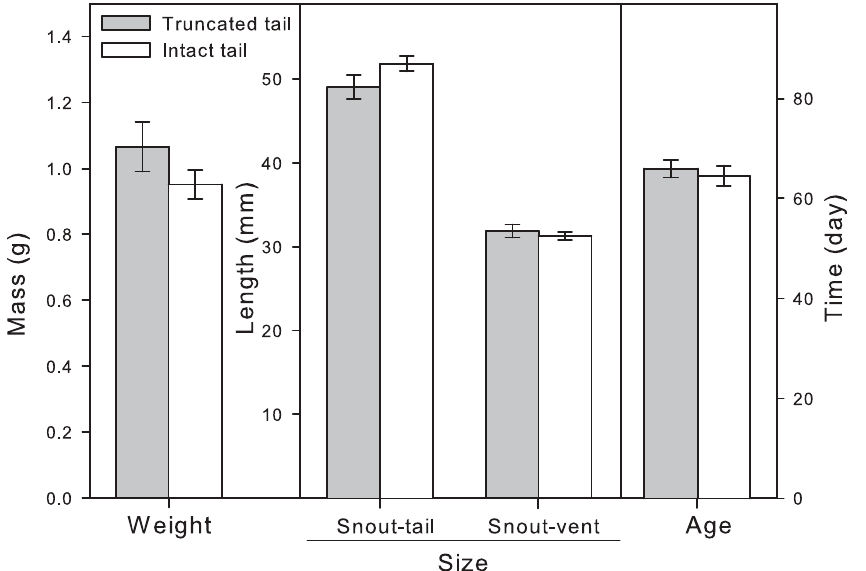
Fig 4. Tail clipping effects on larval Salamandra infraimmaculata mean ( ± SE) mass, snout-tail length, snout-vent length, and time to metamorphosis (Truncated tail [white histogram bars]: N = 20; Intact tail [gray histogram bars]: N =